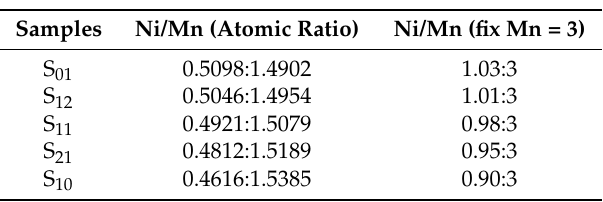
Figure 3. Low-resolution SEM images of spherical precursor prepared by mixed precipitants of (NH 4 ) 2 CO 3 and Na 2 CO 3 with different molar ratios: ( a ) 0:1; ( b ) 1:2; ( c ) 1:1; ( d ) 2:1; ( e ) 1:0. Table 2. ICP-MS results of the LNMO samples prepared by mixed precipitants of (NH 4 ) 2 CO 3 and Na 2 CO 3 with different molar ratios.